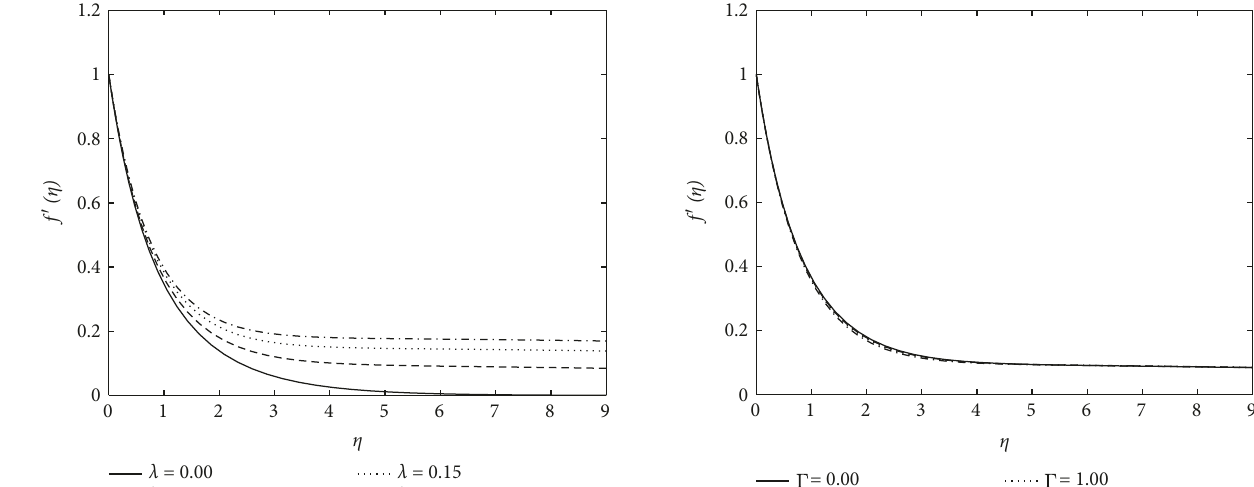
= 1.00 = 2.00 ( η ) for different values of ′